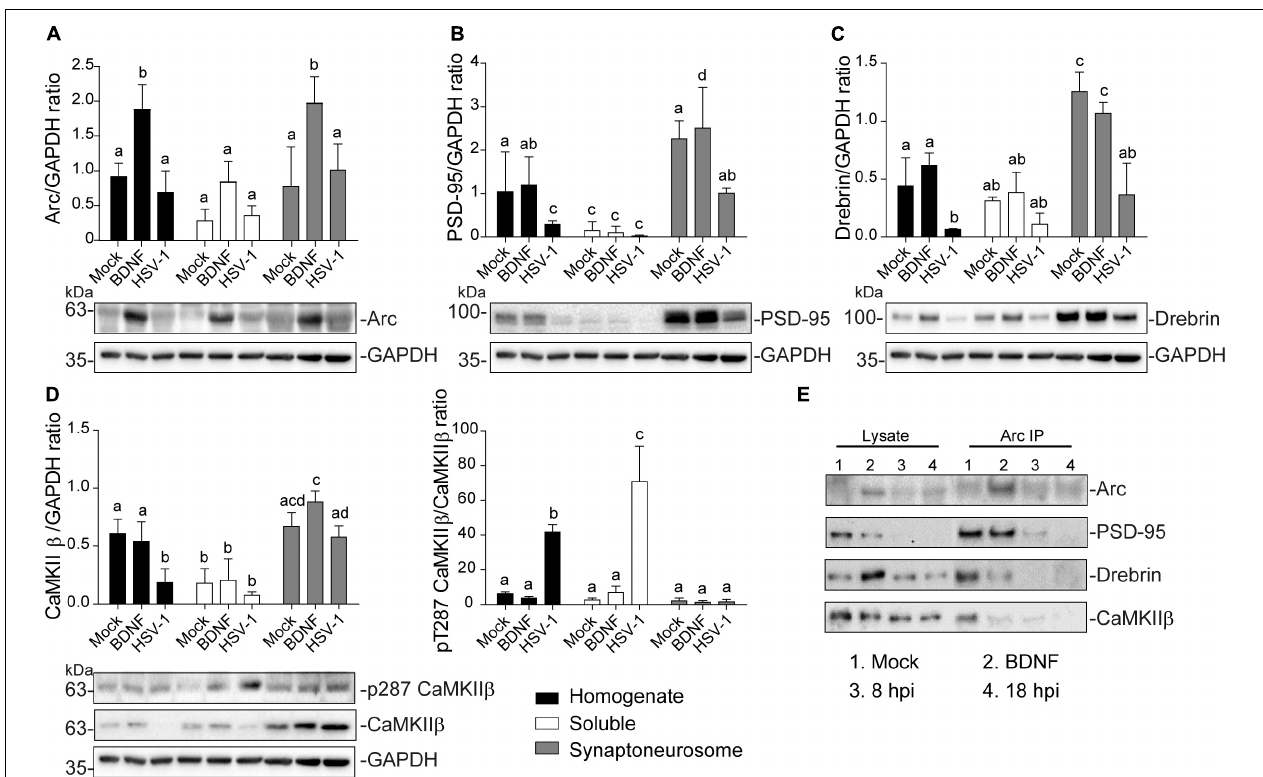
FIGURE 5 | Altered protein content in synaptoneurosomes of HSV-1 infected cortical neurons. Quantification of immunoblot analyses of synaptoneurosomal isolation HSV1-infected and BDNF-stimulated cortical neurons, showing (A) Arc, (B) PSD-95, (C) Drebrin (D) CaMKII β and its activation through T287 phosphorylation. GAPDH was used to normalize each blot. (E) Immunoprecipitation of Arc from the synaptoneurosomal fraction from Mock, BDNF-stimulated and HSV-1 -infected neurons at 8 and 18 hpi. Immunoblot against dendritic binding partners: PSD-95, Drebrin CaMKII β , and β -actin. After gel scanning and densitometry quantitation, the results were expressed as the ratio of protein levels normalized to total GAPDH. Statistical significance was determined by One-Way ANOVA, followed by Tukey’s test. Bars represent the mean ± SD of biological replicates. Different letters above the mean bars apply to significant differences between groups p < 0.05. The blots are representative of three independent